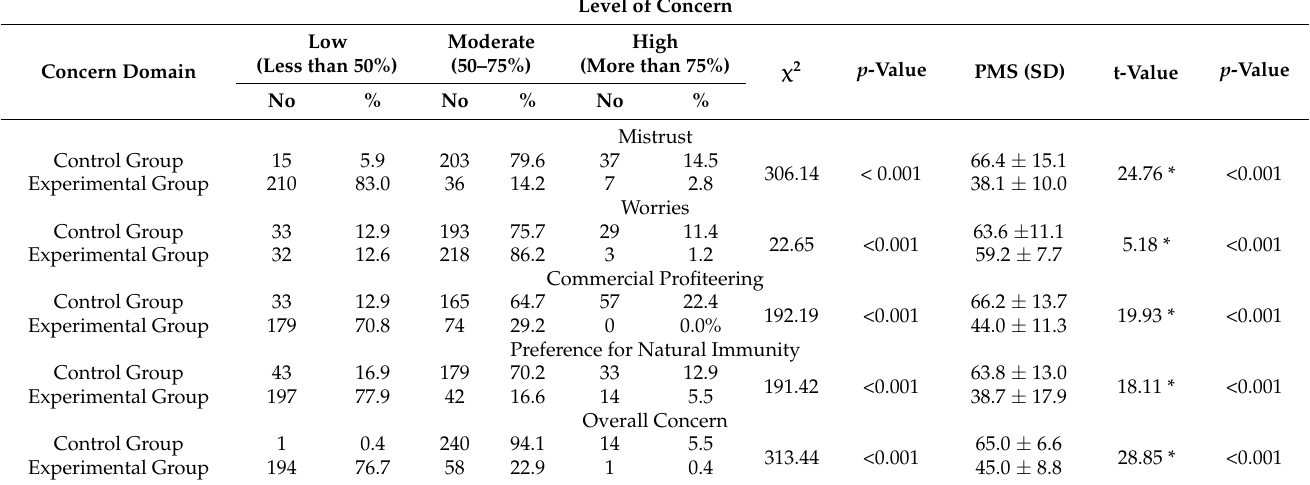
Table 3. Levels of concern about COVID-19 vaccination in different domains of the experimental and control